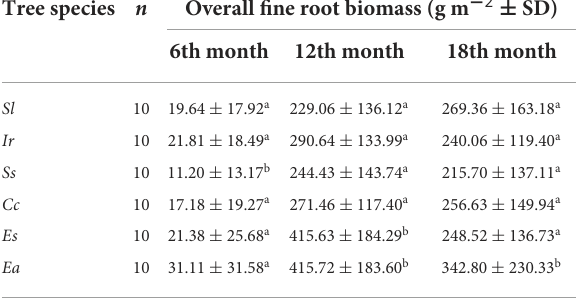
TABLE 1 Overall fine root biomass (g m − 2 ) with standard deviations of all the six tree species from the 6 to 18th month since plantation. Tree species